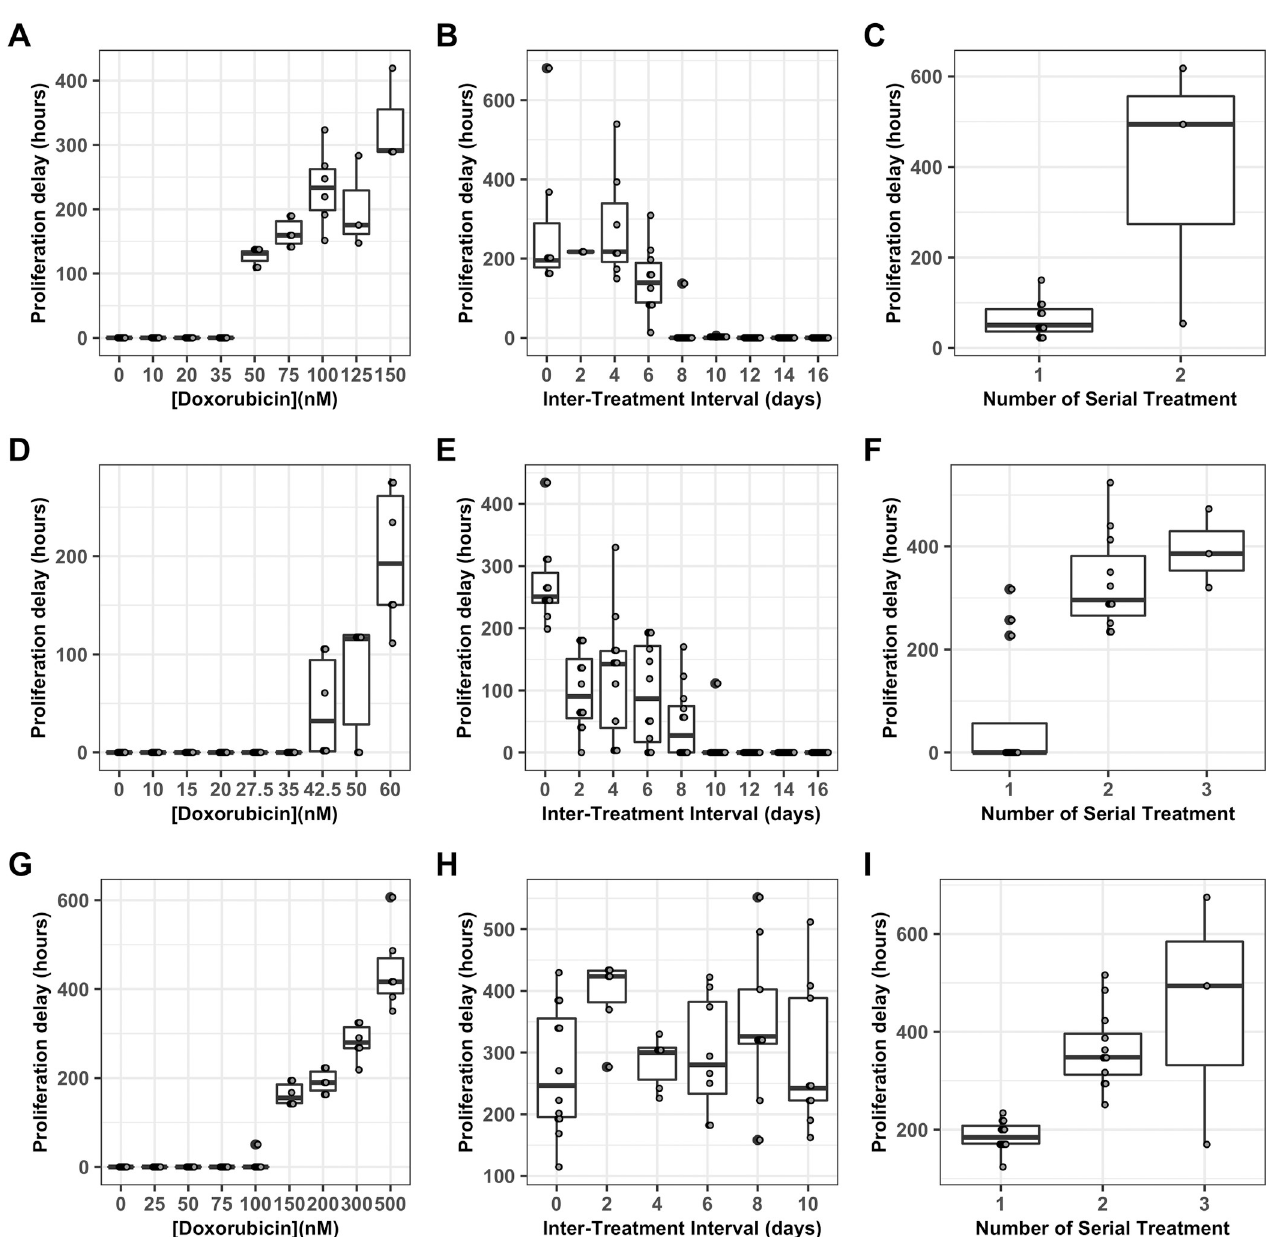
Fig 5. Proliferation delay, t r varies with dosing regimen. Length of growth arrest of resistant cells ( t r ) is displayed as a Tukey box-and-whiskers plot as doxorubicin concentration varies in the MCF7 cell line (A), the BT474 cell line (D), and the MDA-MB-231 cell line (G), as the interval between two 24 hour doxorubicin exposures varies at 75 nM in the MCF7 cell line (B), at 35 nM in the BT474 cell line (E), and at 200 nM in the MDA-MB-231 cell line (H), and as the number of sequential 24 hour doxorubicin exposures varies at a two day interval and 75 nM in the MCF7 cell line (C), at a zero day interval (continuous exposure) and 35 nM in the BT474 cell line (F), and at a two day interval and 200 nM in the MDA-MB-231 cell line (I). The number of replicates in each group varies between 3 and 12; all replicates in which recovery is observed are included (see Fig